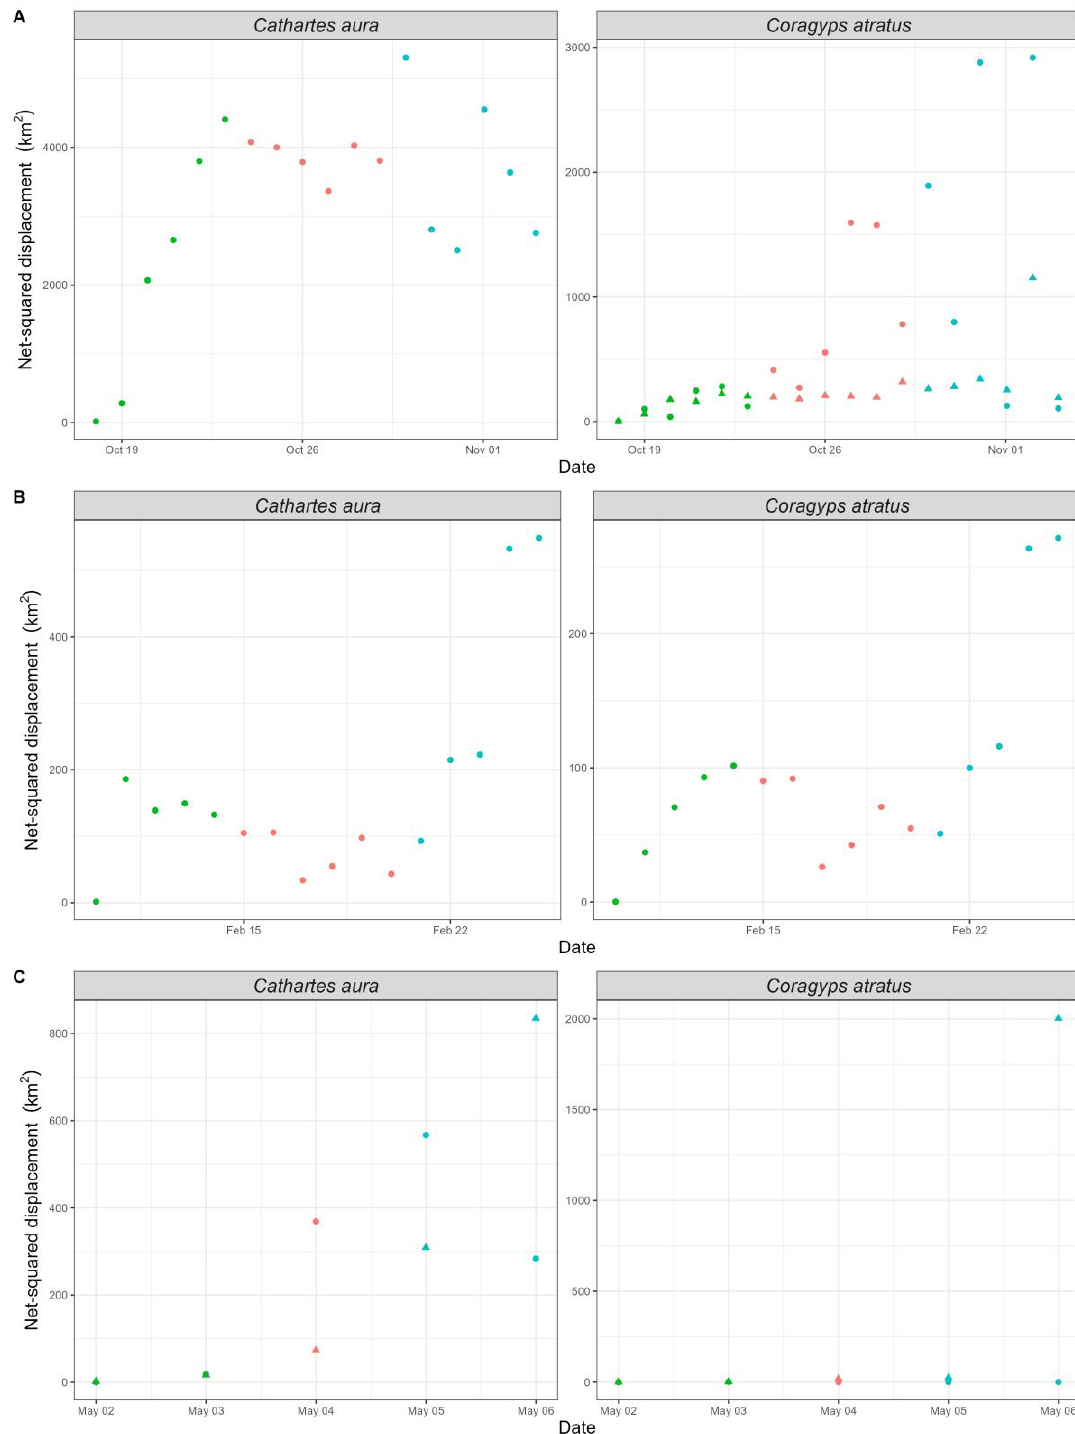
Figure 4. Net-squared displacement (km 2 ) of black and turkey vultures ( Coragyps atratus and Cathartes aura , respectively) before, during, and after extreme weather events in Mississippi, MS, USA. ( Panel A ) = Hurricane Zeta. ( Panel B ) = Winter storm Viola. ( Panel C ) = Tornadoes Duffee and Toomsuba. Green = before the event. Pink = during the event. Blue = after the event. Circles = vultures directly affected. Triangles = vultures not directly affected. Panels without triangles = all birds were directly affected by storms evaluated.